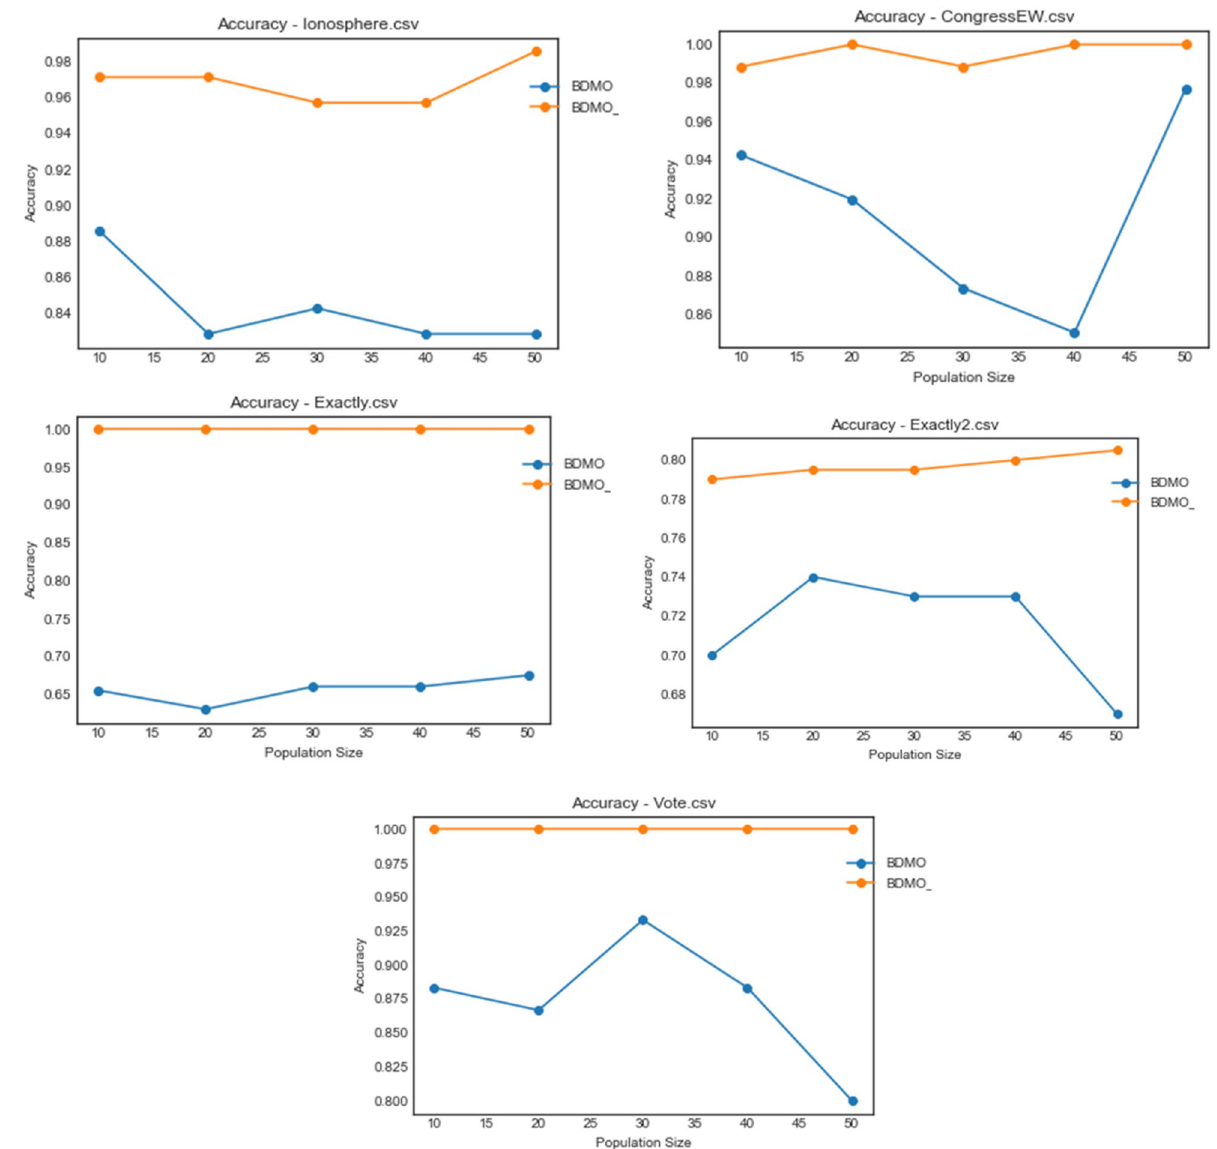
Figure 6. Accuracy plot of the BDMSAO and BDMO on the ionosphere, congressEW, Exactly, Exactly2, and Vote